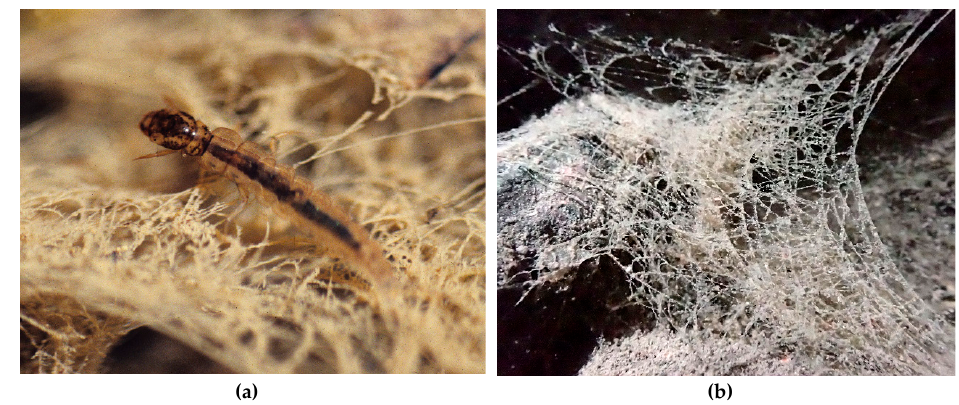
Figure 6. (a) : Larva of Plectrocnemia conspersa (Curtis, 1834) (Polycentropodidae). (b) : Capture net of Figure 6. ( a ): Larva of Plectrocnemia conspersa (Curtis, 1834) (Polycentropodidae). ( b ): Capture net of P. conspersa . Both figures © W. Graf. P. conspersa . Both figures © W.